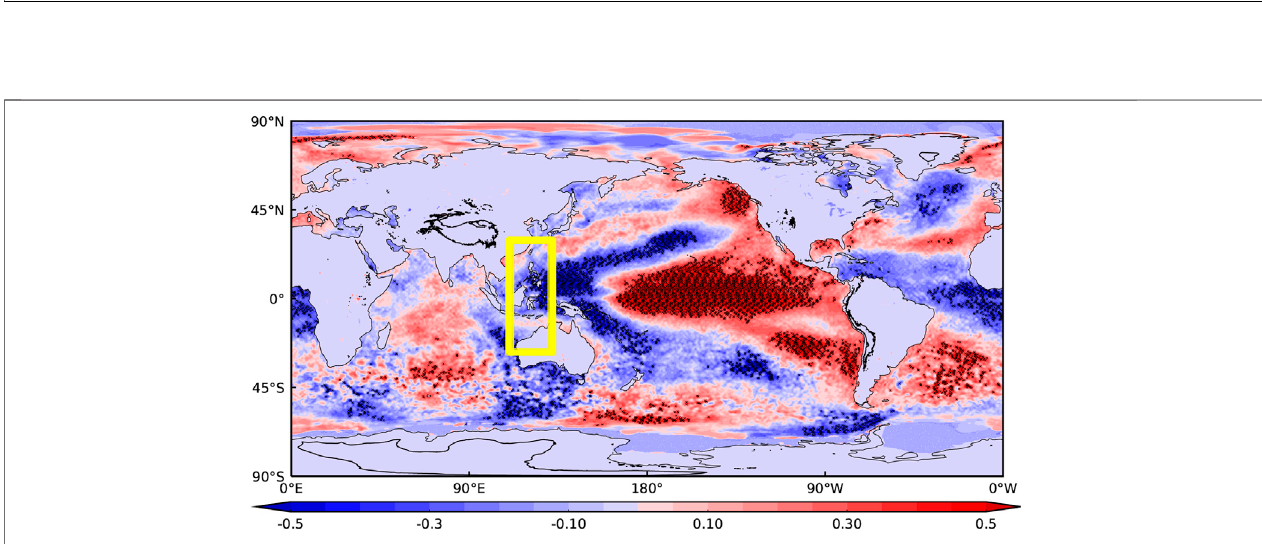
FIGURE 3 | Regression analysis of the SST (shading, unit: K) against the time series of EOF1. Black dots indicate the regressed signi fi cant SSTs at the 95% con fi dence level. The bold black contours denote the topography surpassing 3 km. The yellow box outlines the region from 100 ° E to 120 ° E and 35 ° S to 35 ° N.